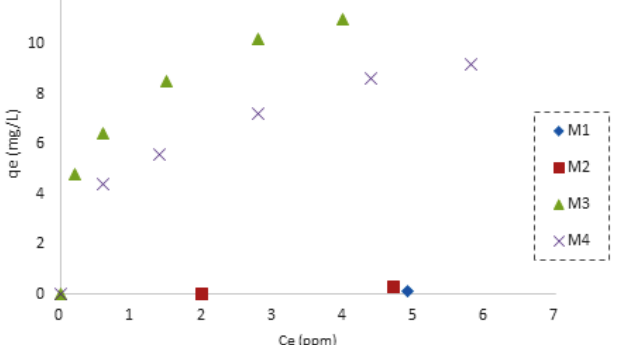
Fig. 2. Water contact angle of prepared membranes